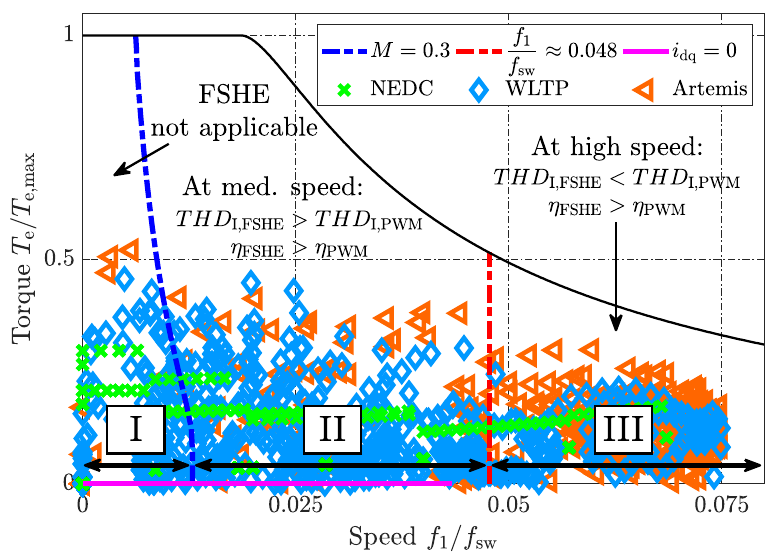
Figure 15. Obtained beneficial operating regions for multilevel PWM and FSHE relative to the normalized torque and relative fundamental frequency considering the current THD I and the drivetrain efficiency η = η Inv η Bat . Table 2. Drive cycle